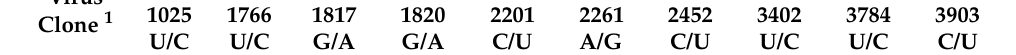
Table 1. Mutations present in the genomic sequences of the virus clones isolated from lineage L1 at transfer 10.